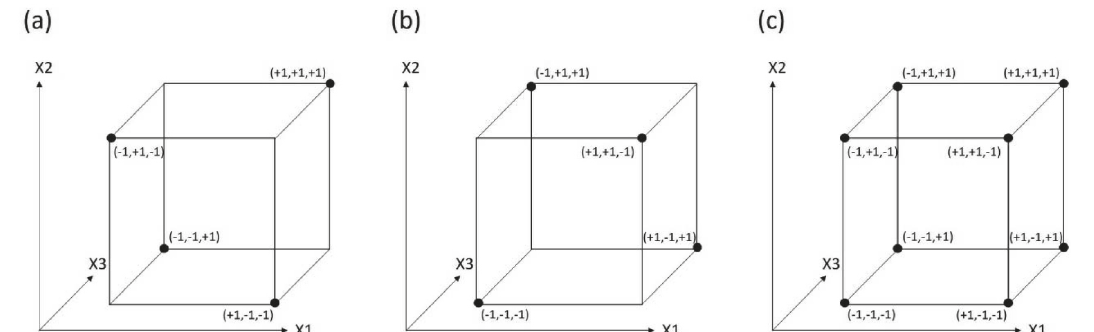
) matrix (a), its complementary matrix (b), and two- III